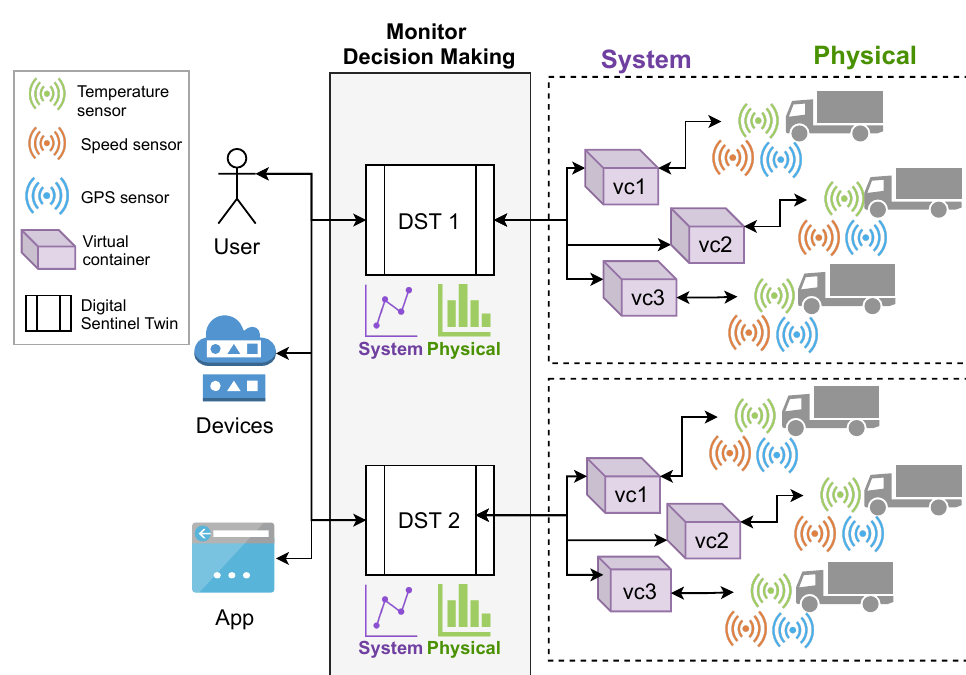
Figure 8. Conceptual representation of the scenario for the case study.